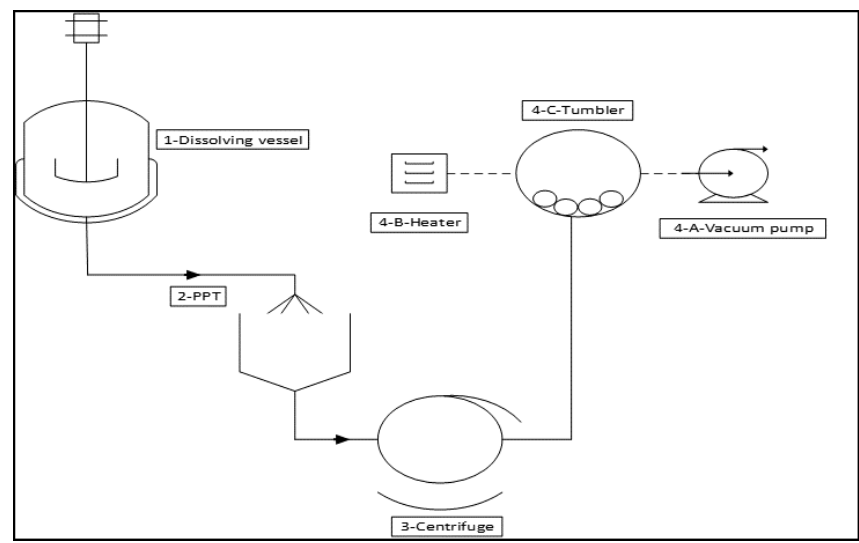
Figure 1. Scheme of the Connora chemical recycling process at plant scale. Table 1. Materials consumption for each phase of the recycling process. Materials (Kg)